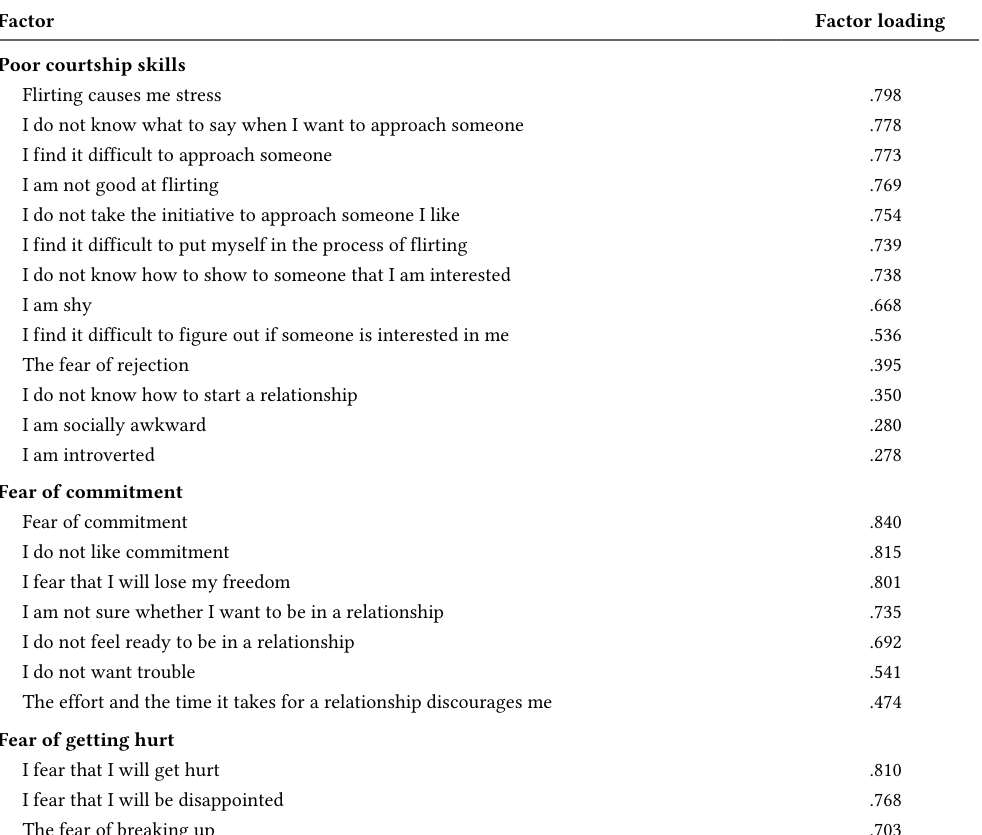
The Extracted Factors and the Respective Factor Loadings for Study